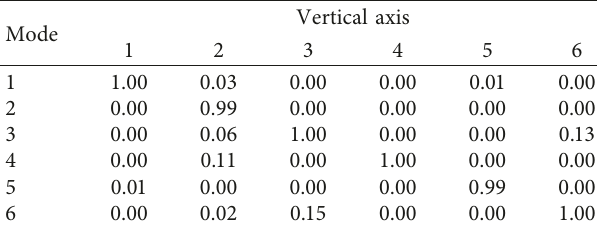
Figure 16: Singular value decomposition (SVD) in the frequency range 0–200Hz. Table 11: MAC between experimental and analytical mode shapes.